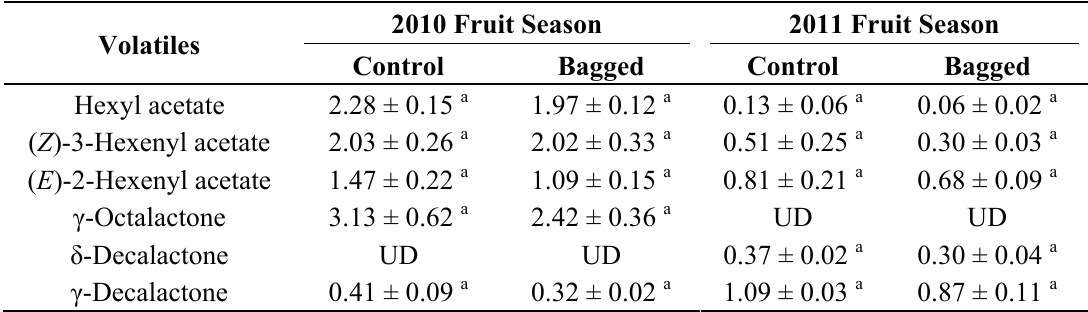
Note: Each value represents the mean ± standard error of three replicates. Values indicated by different letters are significantly different to controls (LSD, 0.05). UD, below the determination limit.